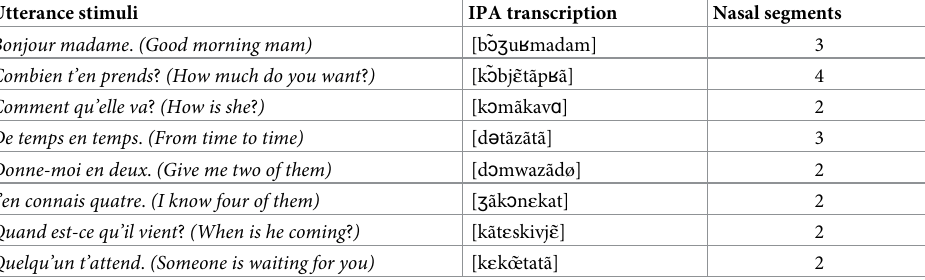
Table 2. The four-syllable utterances used as voice stimuli. Transcripts in regular orthographic Quebec French and IPA. Utterance